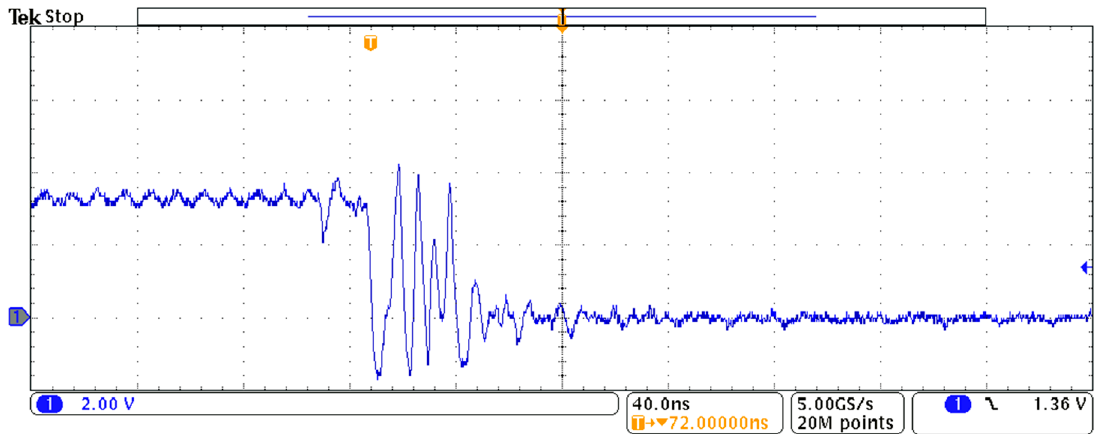
Figure 4. Transitory at the output of the input buffer when the threshold V IL is reached (routed through another buffer to a port of the FPGA to be measured).